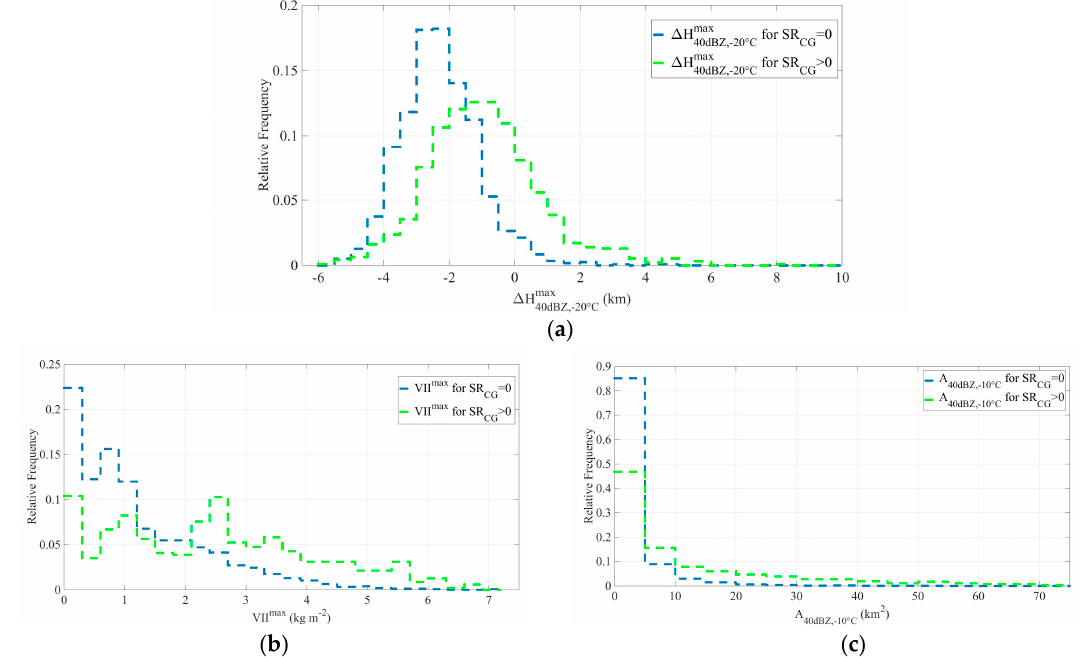
Figure 4. Histograms of ∆ H max 40dBZ, − 20°C ( a ); VII max ( b ) and of A 40dBZ, − 10°C ( c ). The frequency distribution obtained for SR CG = 0 cases is highlighted in blue, whereas the one for SR CG > 0 cases is shown in green. The histograms have been determined from the entire dataset of convective cells.